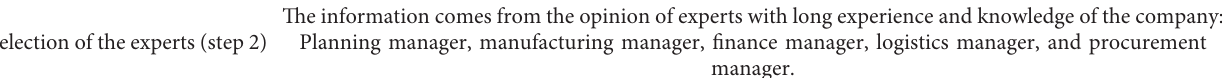
Table 7: Application of step 2 of the methodology (selection of the experts).